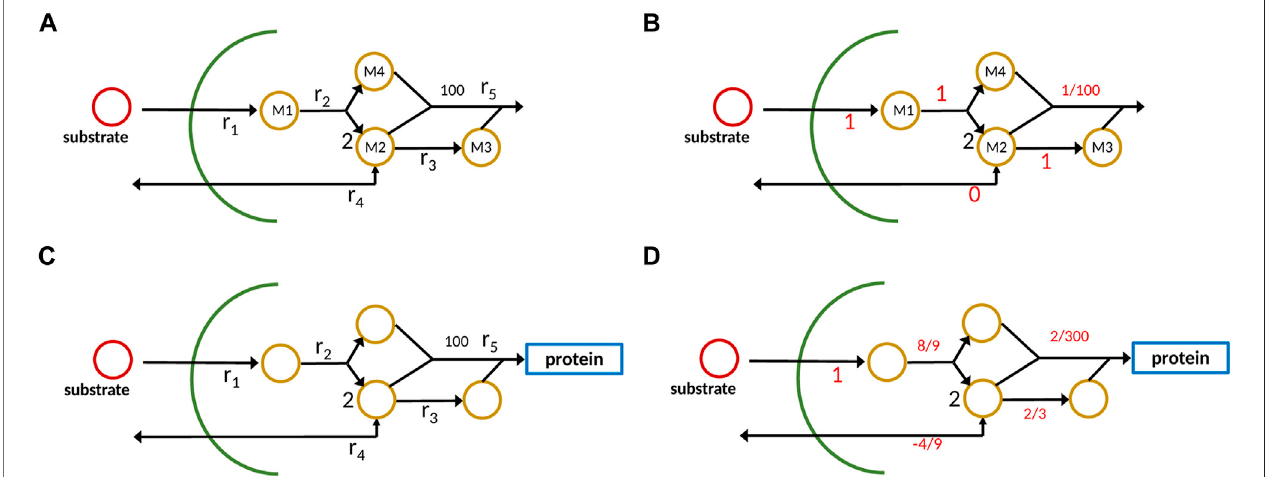
FIGURE 2 | Example network with metabolites M i and reactions r i ; conventional representation (A) , new approach with one component representing protein/ biomass sector (C) . On the right side (B,D) , output data from the calculationsare shown;it istobe noted that for thenew approach, thedilution term must be taken into account which is not shown in the